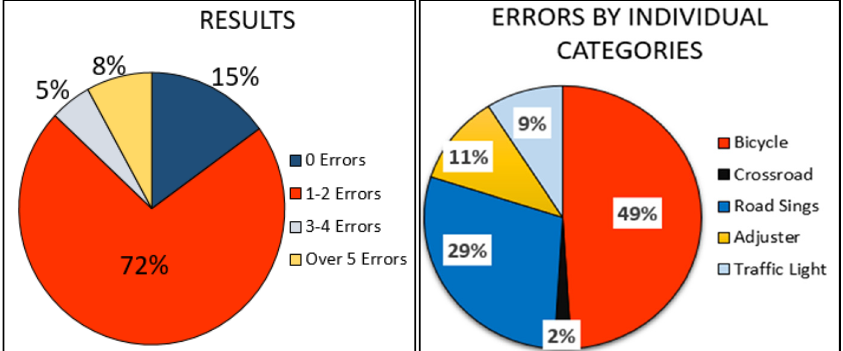
Figure 14. Results from the experimental training with the game environment in STEM centers.